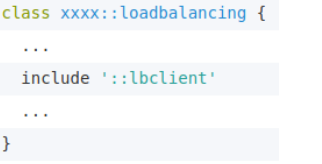
Figure 3. Puppet manifest to include lbclient